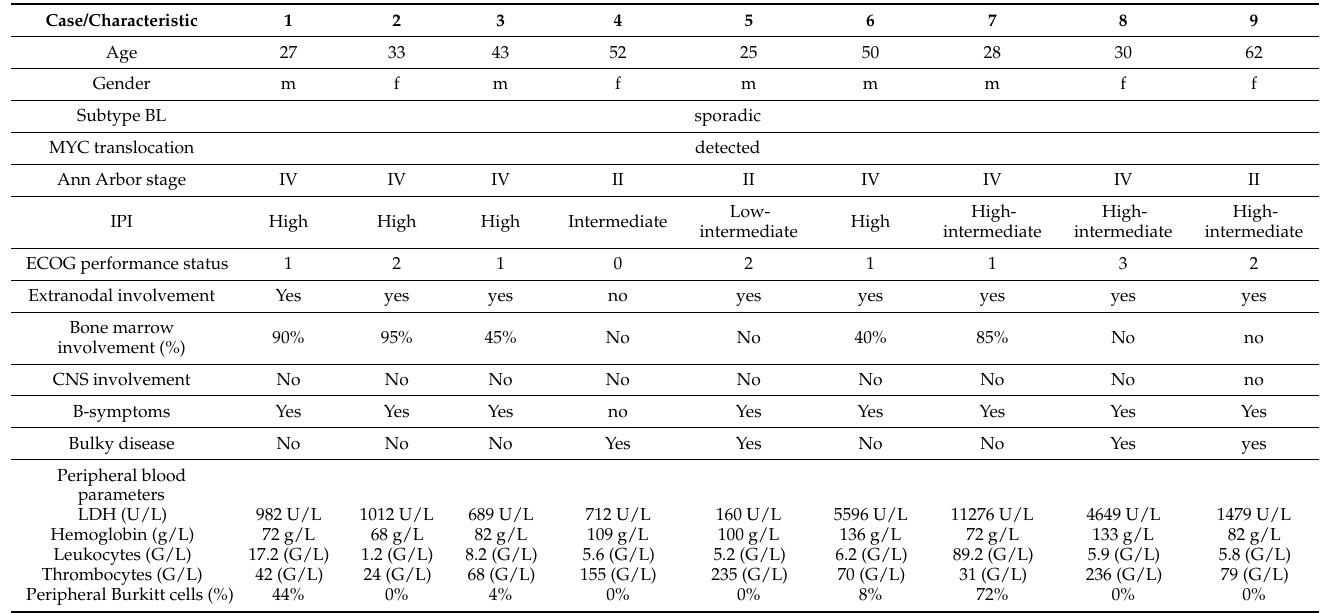
Table 1. Patient characteristics at first